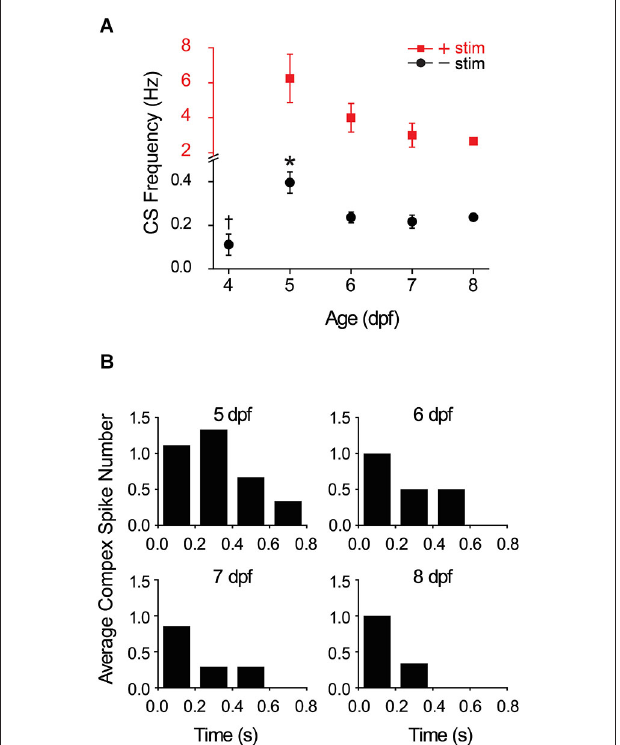
FIGURE 4 | Development and winnowing of functional connections between climbing fibers and Purkinje cells. (A) The average frequency of complex spiking in Purkinje cells in the absence (black circles) and presence (red squares) of direct electrical stimulation of the inferior olive has been plotted vs. age. Note change in vertical scale for data obtained in the absence (black) and presence (red) of stimulation. In the absence of stimulation, complex spike frequency was averaged over 10 s recordings; the frequency at 5 dpf (0.4 Hz) was significantly higher than on all subsequent days ( ∗ , ANOVA: 4–8 dpf, F ( 4,67 ) = 6.17, p = 2.75 × 10 − 4 , followed by Tukey’s post hoc test: p < 0.05; n = 6–20 cells, 5–17 animals). The frequency at 4 dpf (0.11 Hz) was significantly lower than that measured at 6 dpf (0.24 Hz) (†, ANOVA: 4–8 dpf, F ( 4,67 ) = 6.17, p = 2.75 × 10 − 4 , followed by Tukey’s post hoc text: p < 0.05; n = 7 and 20 cells, 6 and 14 animals at 4 and 6 dpf, respectively). Complex spike frequency did not vary significantly between 6 and 8 dpf (ANOVA: 4–8 dpf, F ( 4,67 ) = 6.17, p = 2.75 × 10 − 4 , followed by Holm-Bonferroni post hoc test: 6–8 dpf, p ≥ 0.05; n = 6–20 cells, 5–14 animals). In the presence of stimulation, the frequency of complex spiking was averaged over the first 500 ms after the stimulus. Evoked complex spike frequency decreased from 6.3 Hz at 5 dpf ( n = 9 cells, 4 animals) to 2.7 Hz at 8 dpf ( n = 3 cells, 3 animals) (Spearman’s rank correlation, r = − 1). Electrical stimulation increased complex spike frequency by ∼ 16-fold at 5–6 dpf and by ∼ 12-fold at 7–8 dpf. (B) Complex spiking was evoked by direct electrical stimulation of the inferior olive at 5–8 dpf. The average number of complex spikes per 200 ms bin after the stimulus has been plotted ( n = 3–9 cells, 3–4 animals). Cells that did not fire complex spikes in the absence of stimulation were excluded from the